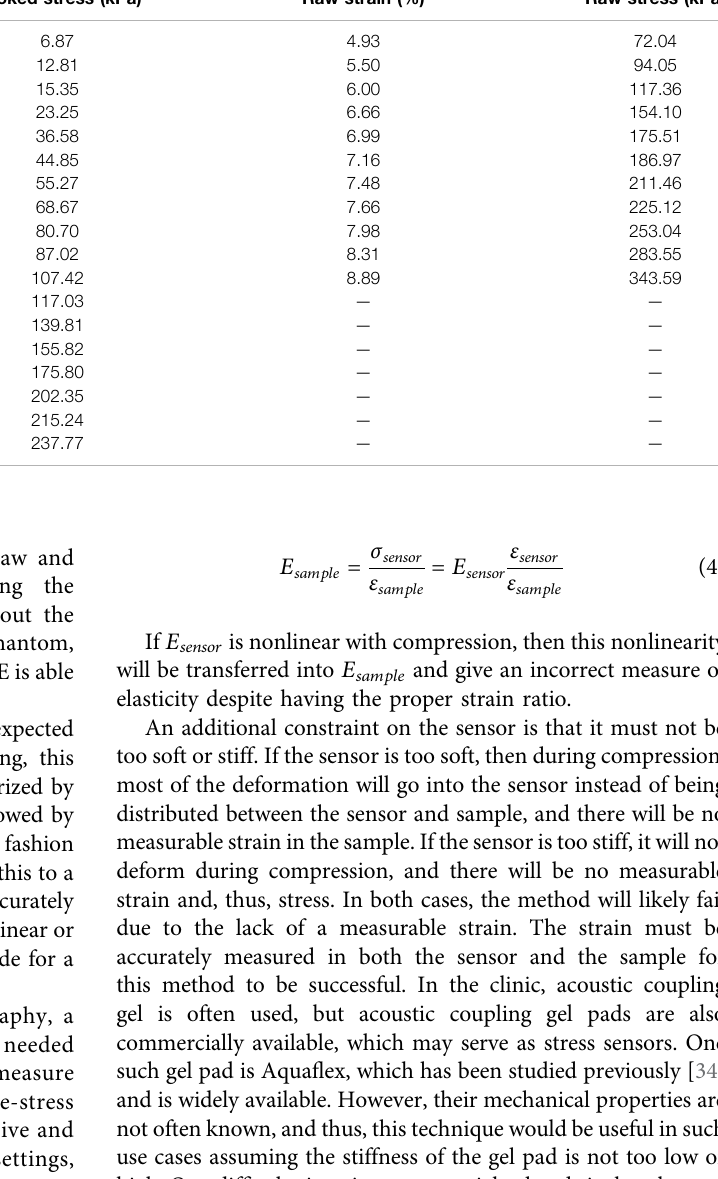
TABLE 2 | Values of stress and strain for the cooked and uncooked sides of the steak experiment. Steak Step Cooked strain (%) Cooked stress (kPa) Raw strain (%) Raw stress